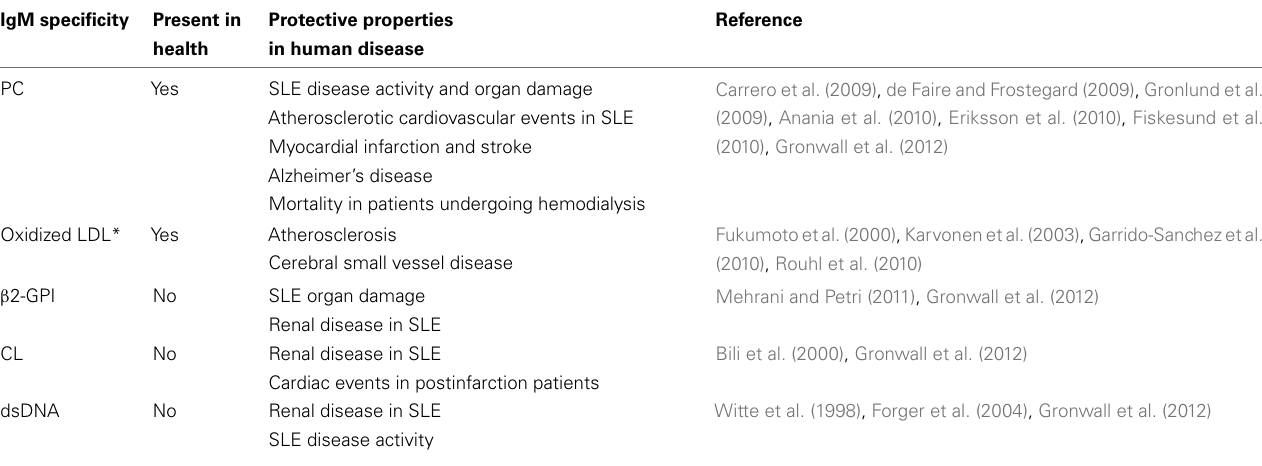
Table 1 | Specific IgM antibody levels correlate with protection from human